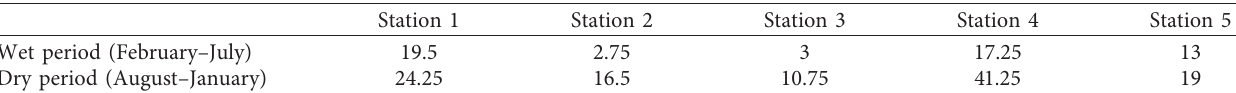
Table 3: Calculated values of catch per unit effort of P. algeriense of 5 stations along Zegzel